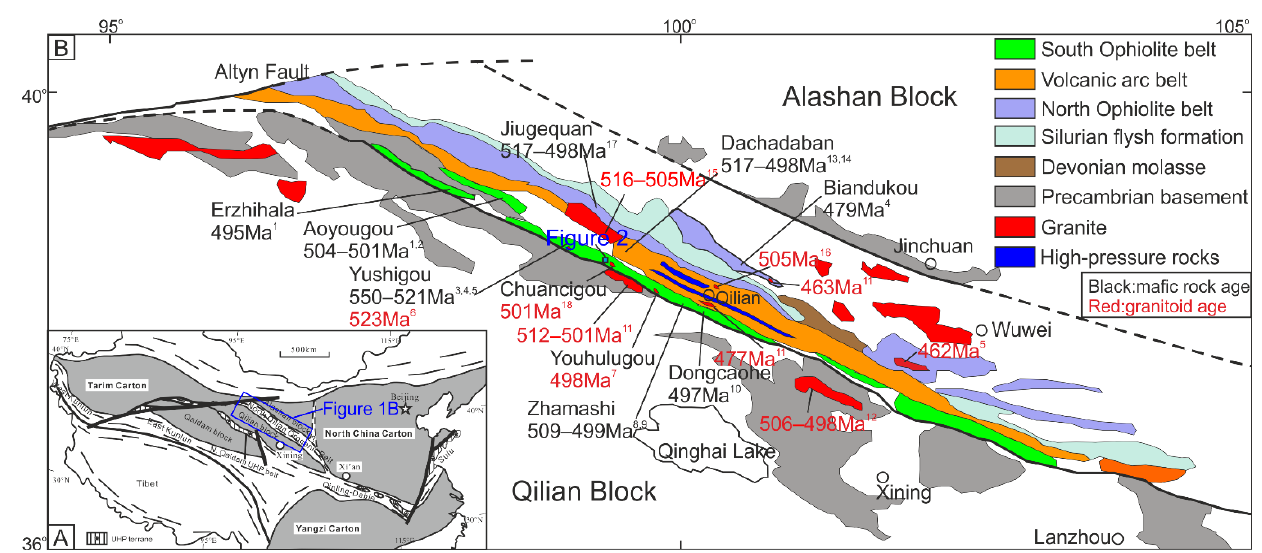
Figure 1. Geological map of the NQOB modified after Song et al. (2013) [16]. ( A ) is a schematic map showing major tectonic units of China and ( B ) is a geological map showing ages of the NQOB and Qilian Block. References: [31] 1 , [32] 2 , [33] 3 , [16] 4 , [18] 5 , [34] 6 , [35] 7 , [36] 8 , [37] 9 , [38] 10 , [39] 11 , [40] 12 , [41] 13 , [42] 14 , [43] 15 , [44] 16 , [45] 17 , [46] 18 .